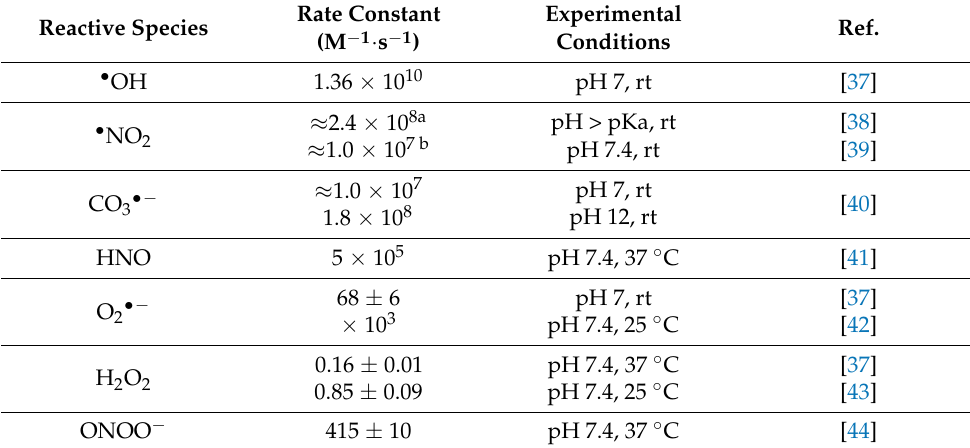
Table 1. Rate constants of N -acetylcysteine reactions with various compounds under different experimental conditions. Rate Constant Experimental Reactive Species (M − 1 · s − 1 ) Conditions